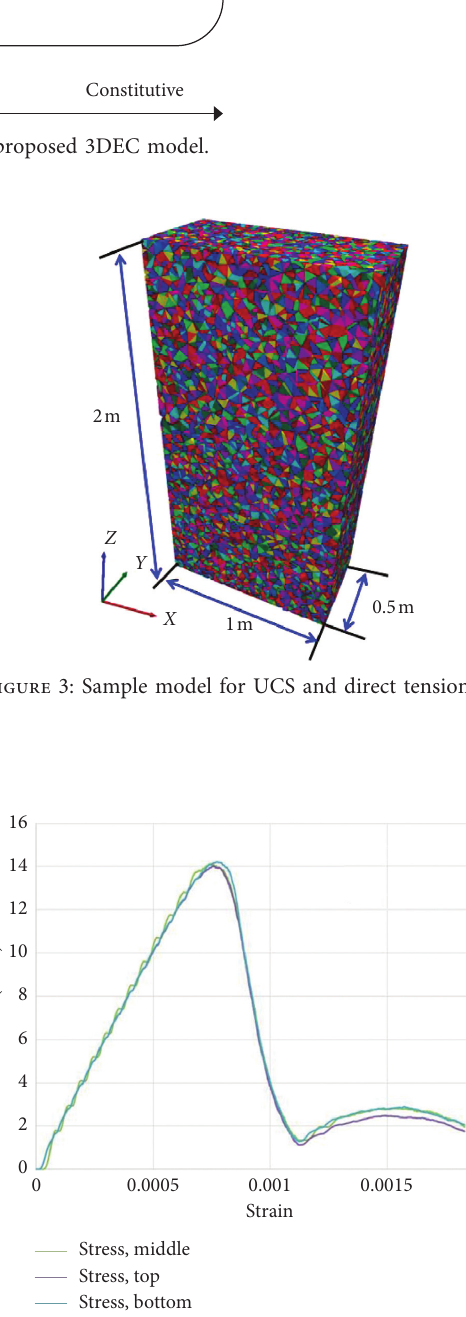
Figure 4: Stress-strain curve for the UCS test used to benchmark rock